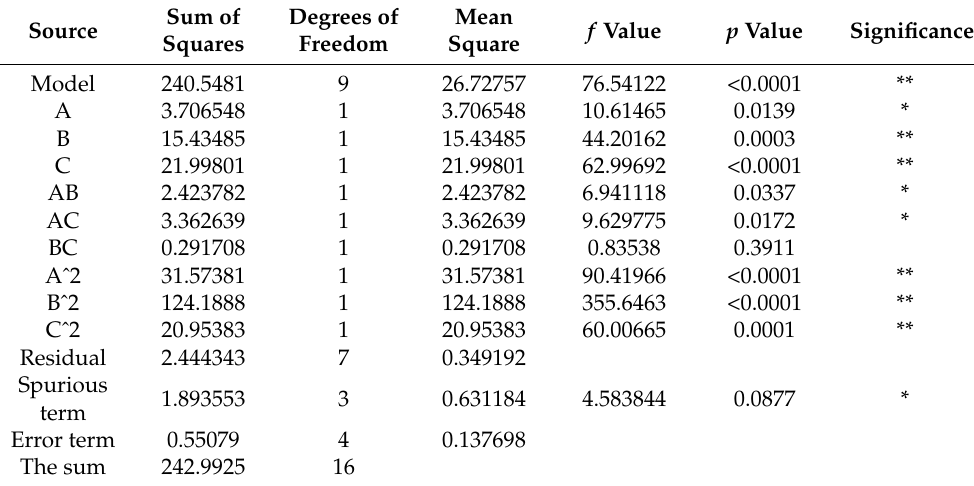
Table 4. Analysis of